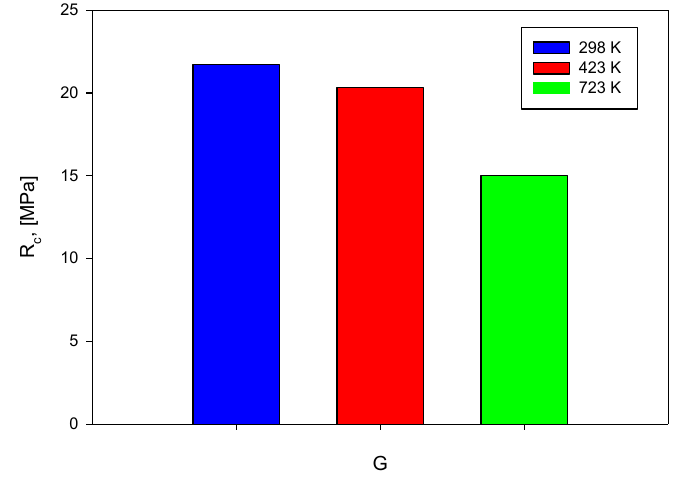
Figure 14. Geopolymer concrete compressive strength R